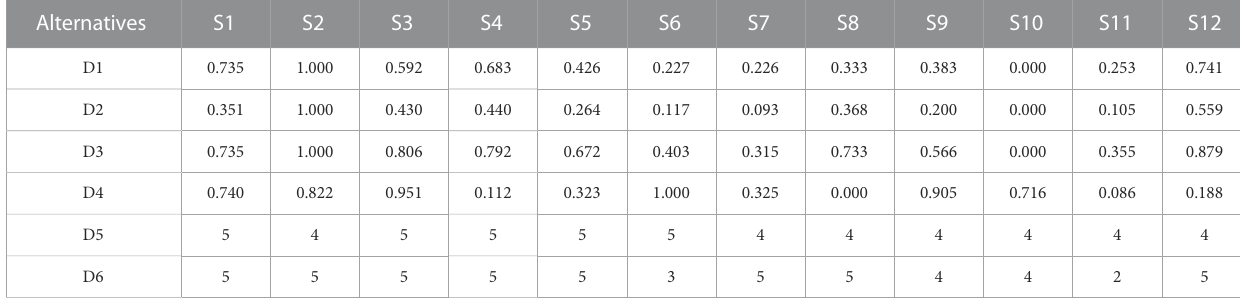
TABLE 6 Results of evaluation indices for